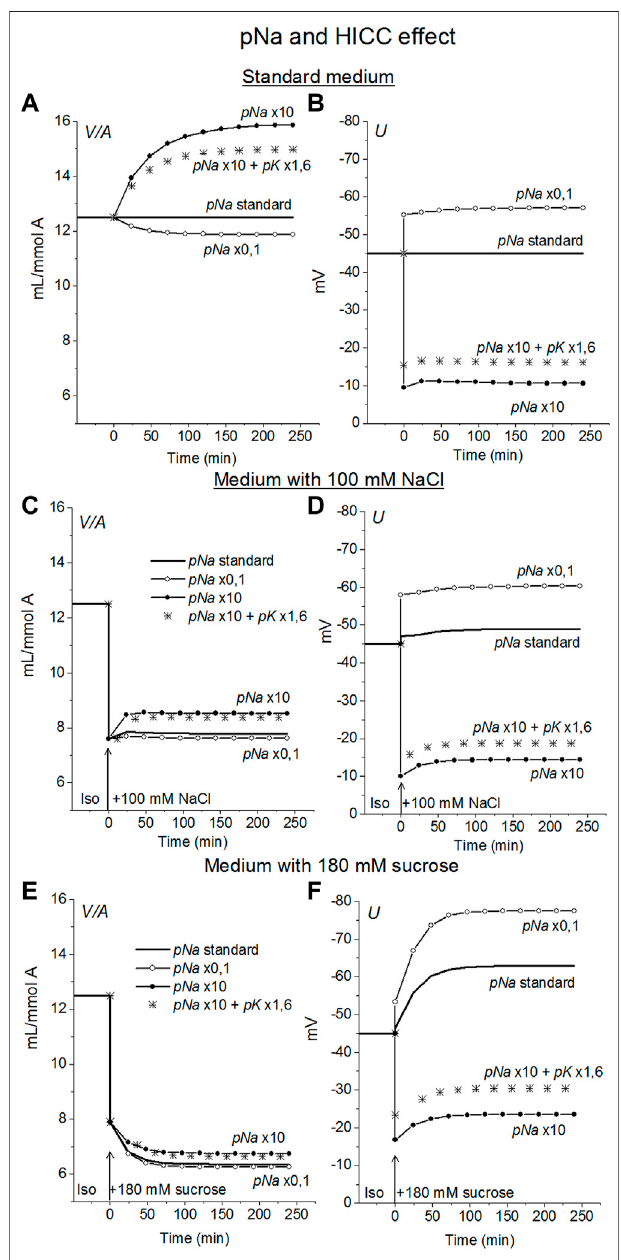
FIGURE 5 | The effect of changes in the Na + and HICC channel permeability coef fi cients on ion homeostasis in the U937 cell model under standard conditions (A,B) and in a hyperosmolar medium with 100 mM NaCl (C,D) or 180 mM sucrose (E,F) . The calculation was carried out for a model with a full set of cotransporters. Changes in pNa , and HICC ( pNa + pK ) are shown in the graphs, other parameters remained unchanged and are shown in Table 2